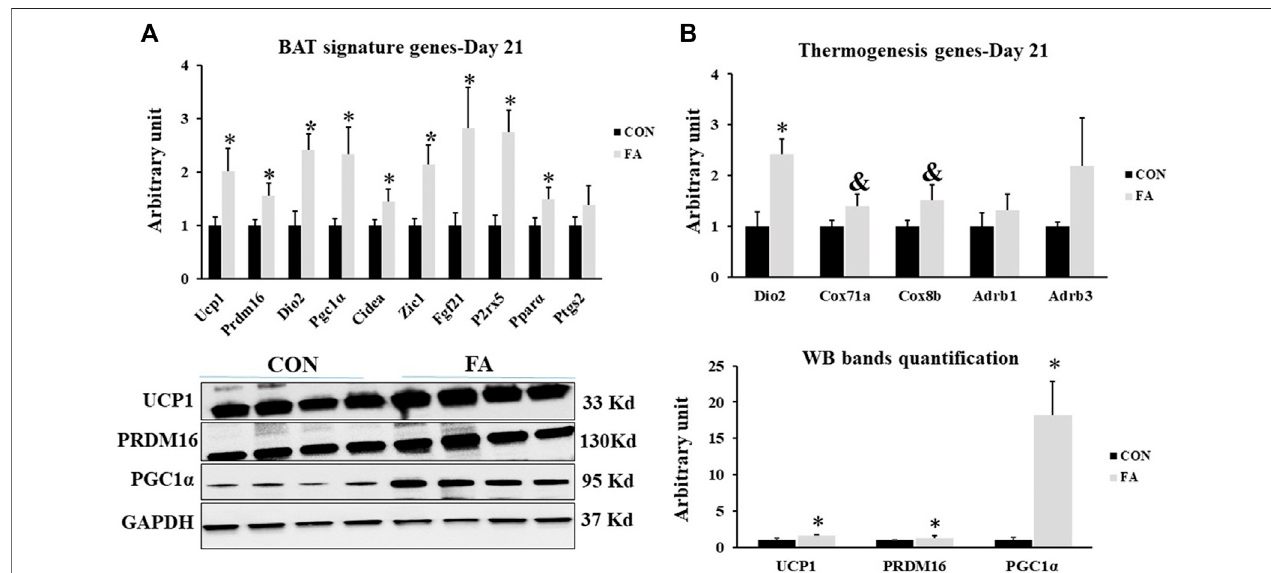
FIGURE 11 | Effect of maternal intake of EPA/DHA on BAT signature genes expression in weaned mice (D21). The mothers were fed either control diet (CON) or EPA/DHAenriched diet(FA)duringtheentireperiod ofpregnancyand lactation (A) QuantitativeRT-qPCR( n =8)andrepresentativeimage anddensitometric analysisof westernblot( n =4)ofkeygenesregulatingBATactivityanddevelopmentinweanedmice,3 weekspostpartum (B) TheQuantitativeRT-qPCR( n =8)andrepresentative image and densitometric analysis of western blot ( n = 4) relative expression of genes involved in regulating the thermogenesis activity in weaned mice, 3 weeks postpartum. The raw Ct was normalized to the value of 18 s. All data represent as mean ± SEM. p < 0.05 by Student ’ s t-test.